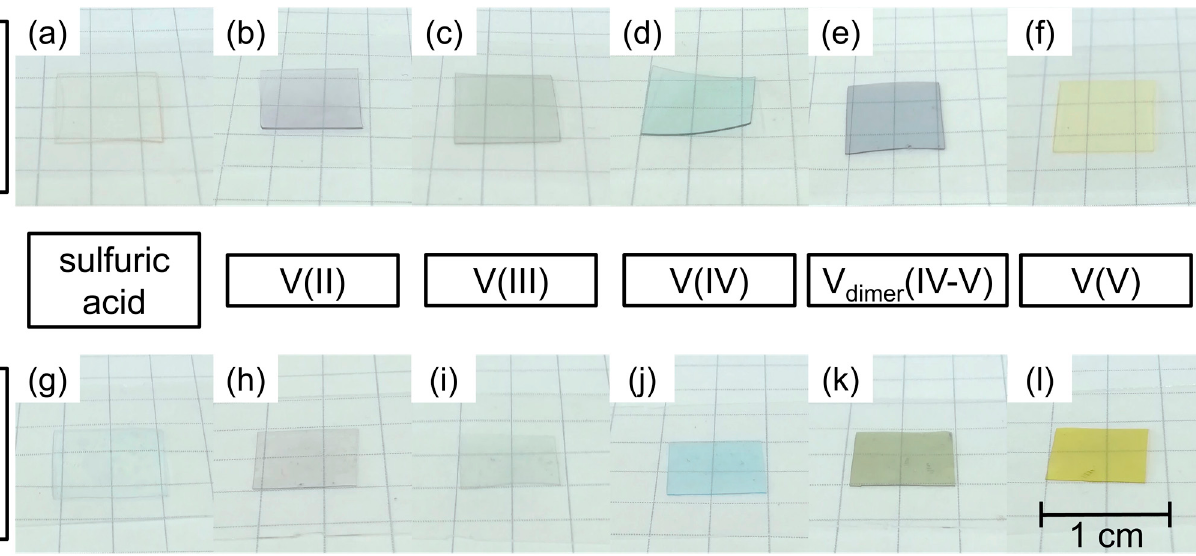
Figure 7. Photographs of Nafion™ hydrated with ( a ) 4 M sulfuric acid and hydrated with 1.6 M vanadium electrolyte ( b ) V(II), ( c ) V(III), ( d ) V(IV), ( e ) V dimer (IV–V), and ( f ) V(V), and PVDF-based membrane hydrated with ( g ) 4 M sulfuric acid and hydrated with 1.6 M vanadium electrolyte ( h ) V(II), ( i ) V(III), ( j ) V(IV), ( k ) V dimer (IV–V), and ( l ) V(V).